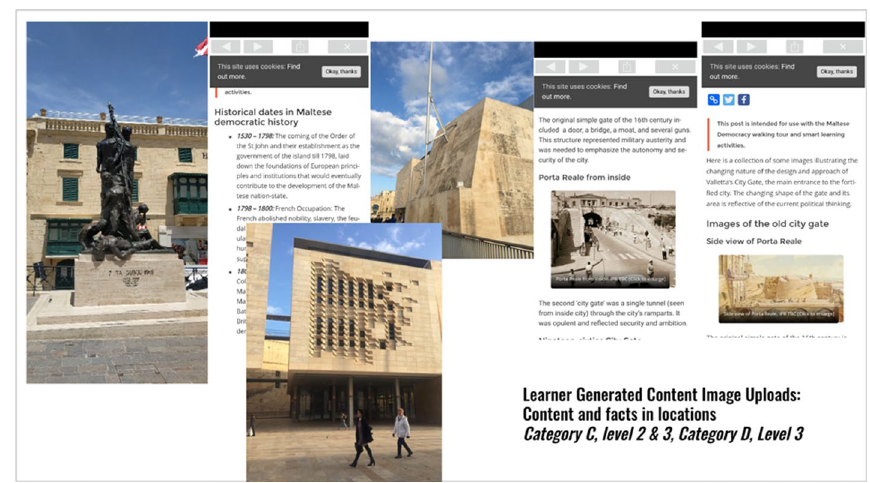
Fig. 2 LGC images reflecting Category C, Level 2 and 3, Category D, Level 3